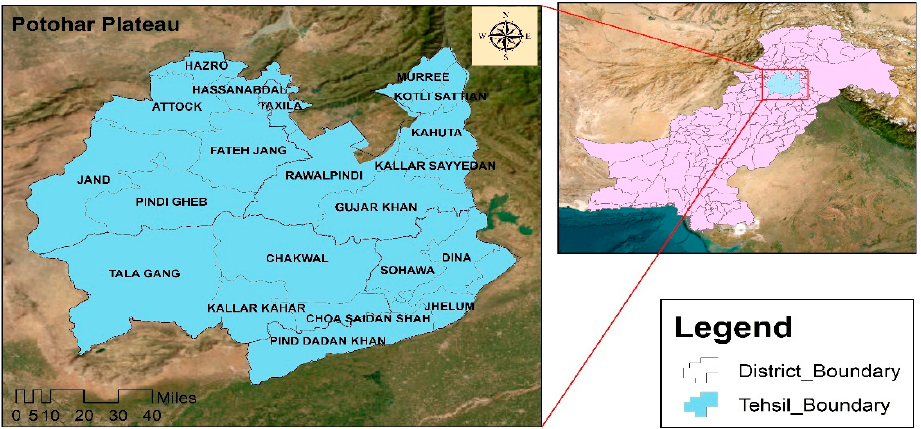
Figure 2. Location map of the study area (Potohar Plateau).